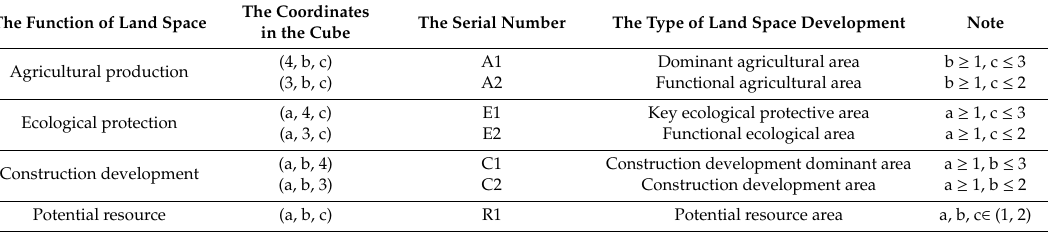
Table 3. The land space development zoning principle.